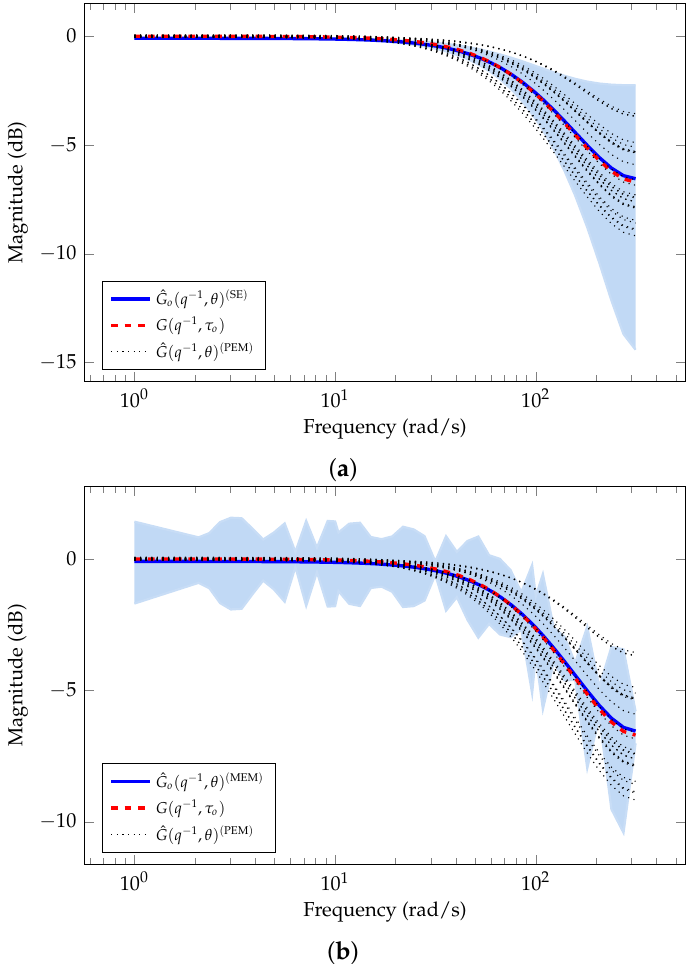
Figure 4. Nominal model and uncertainty region estimated using SE and MEM for Example 2. ( a ) System model estimated with SE. ( b ) System model estimated with